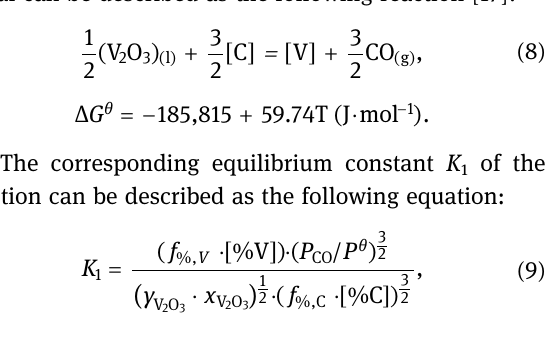
Figure 4: Composition ( wt% ) of hot metal produced in the VTM smelting BF over the 1 year ( 2021 – 2022 )